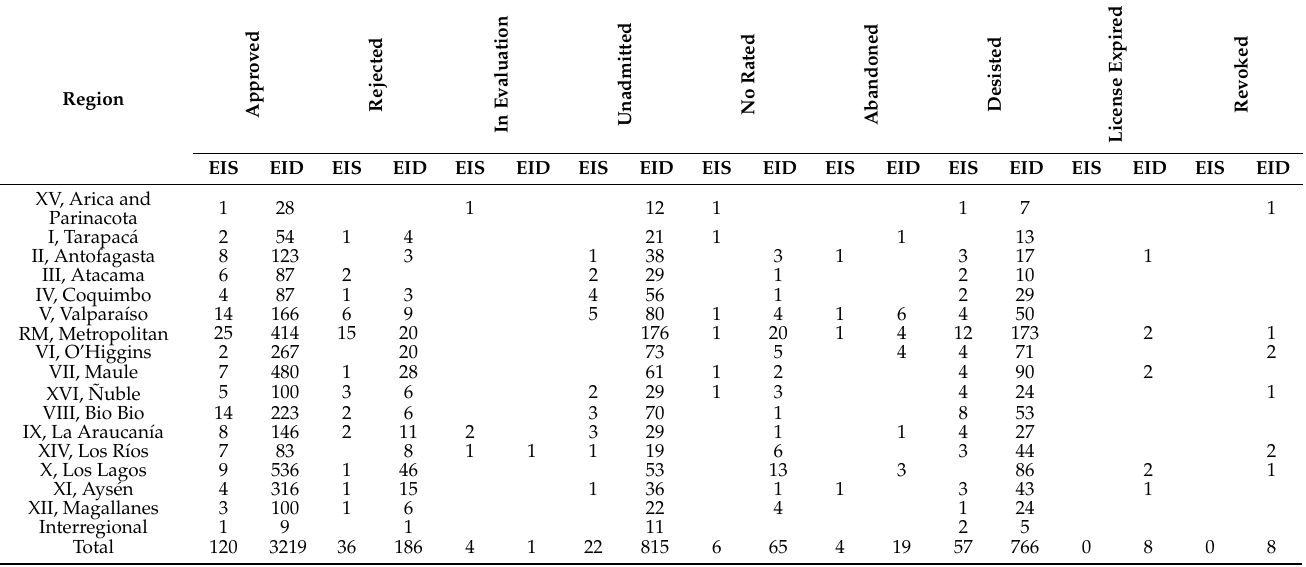
Table A1. Compiled sanitation projects by region entered as EIS and EID in the Chilean EIA